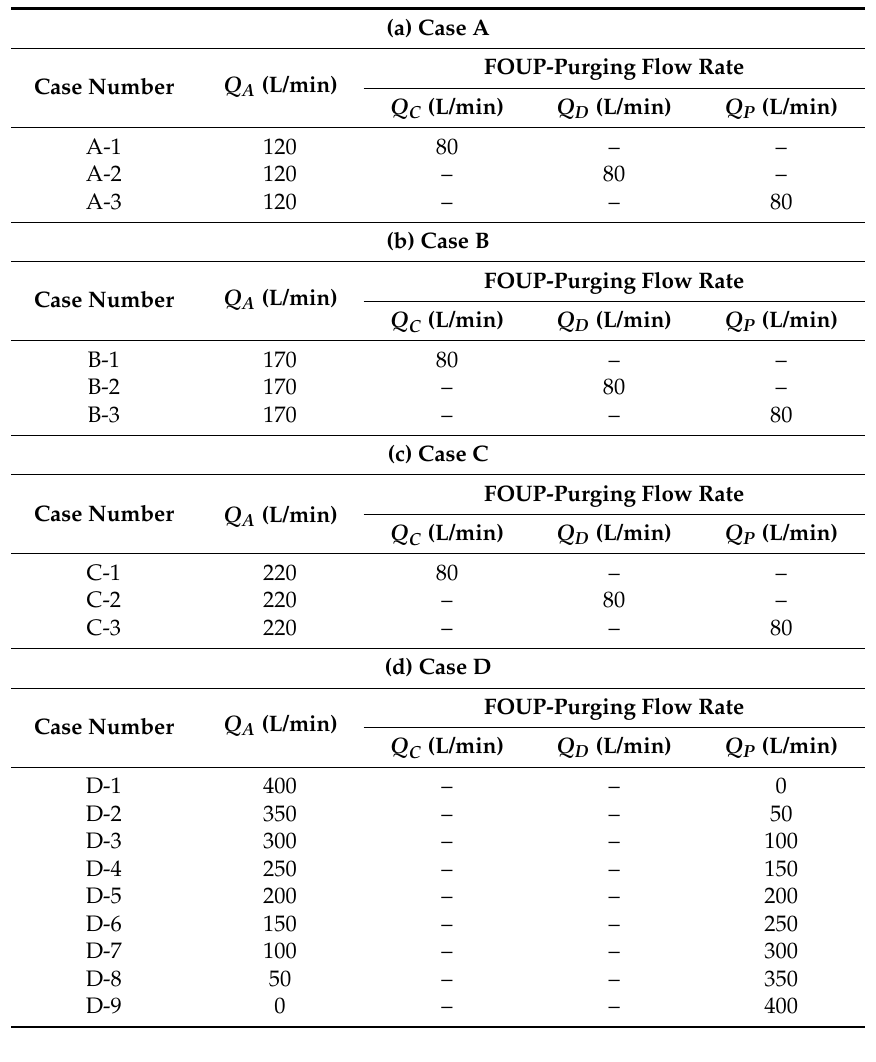
Table 1. Test conditions of experiments. FOUP—front opening unified